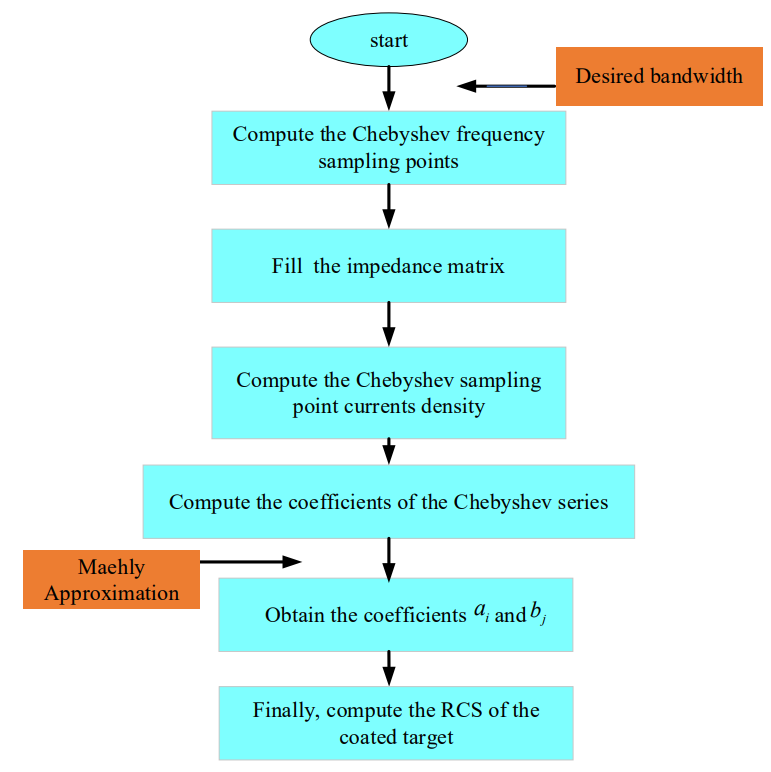
Figure 4. The EFIE-PMCHWT-CAT flowchart.